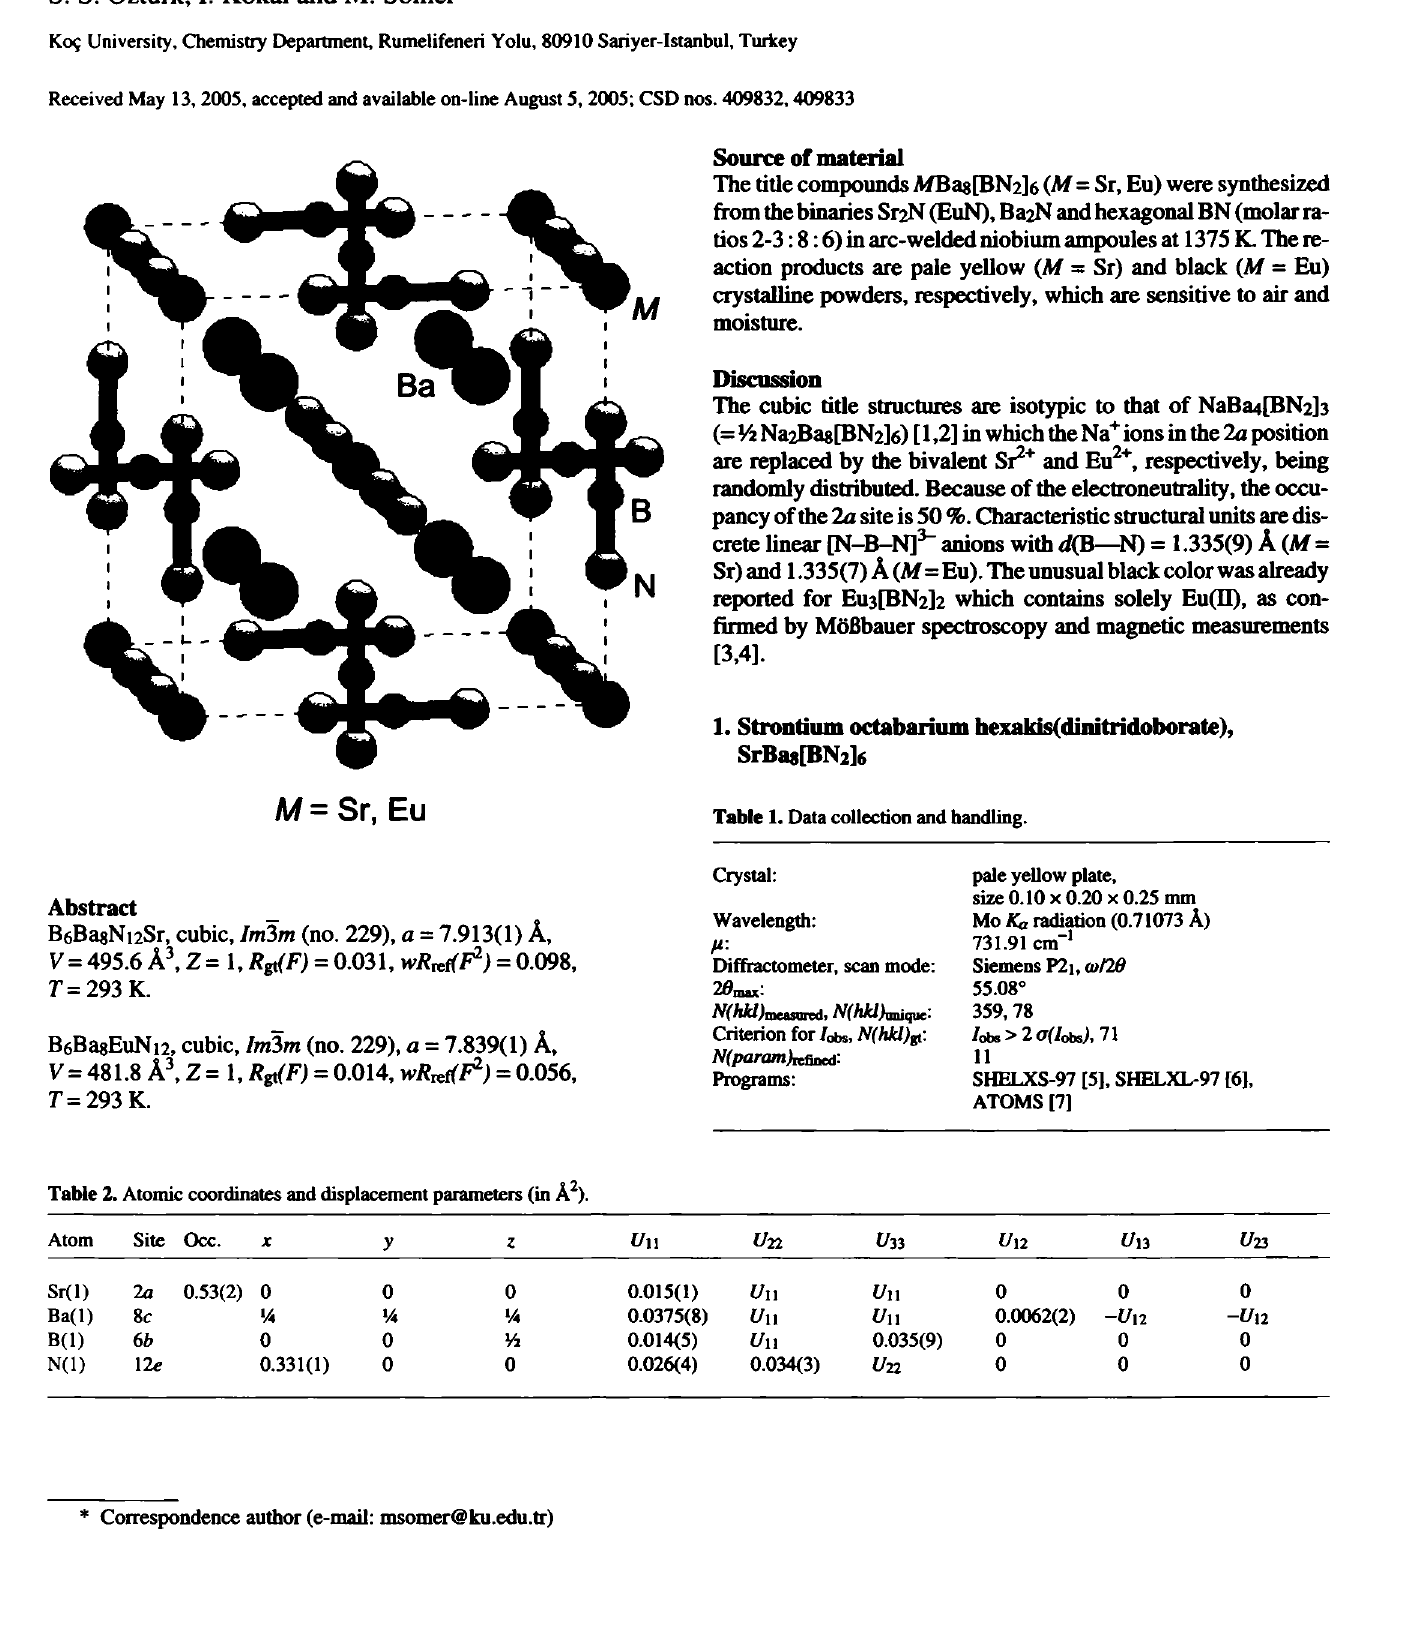
Table 2. Atomic coordinates and displacement parameters (in Ä 2